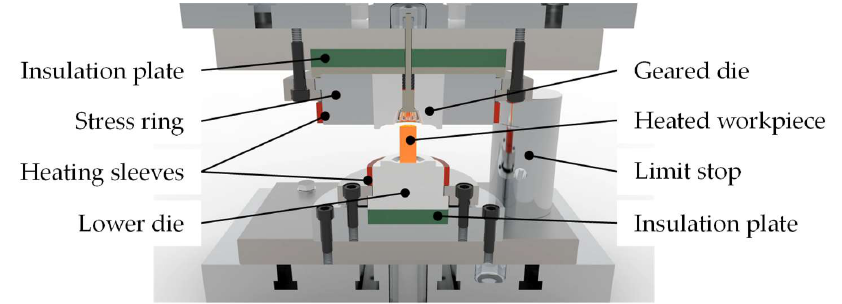
Figure 3. Forging tool system for manufacturing hybrid bevel gears.